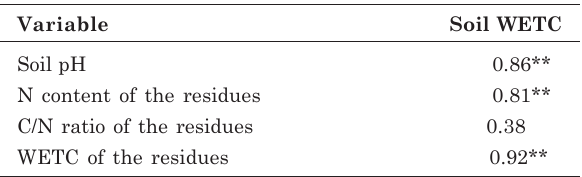
WETC, water-extractable total carbon. ** Significant at 1